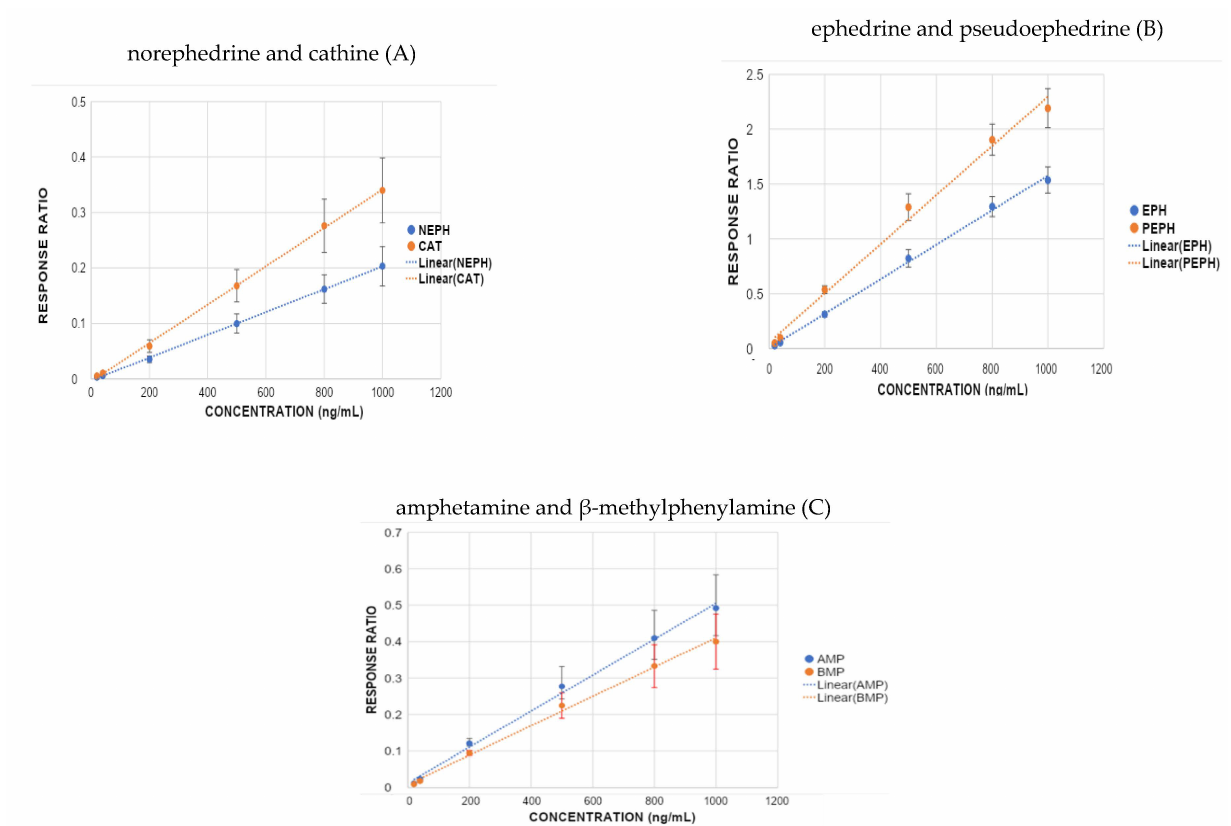
Figure 5. Averaged quadratic calibration curves of ( A ) norephedrine and cathine, ( B ) ephedrine and pseudoephedrine, and ( C ) amphetamine and β